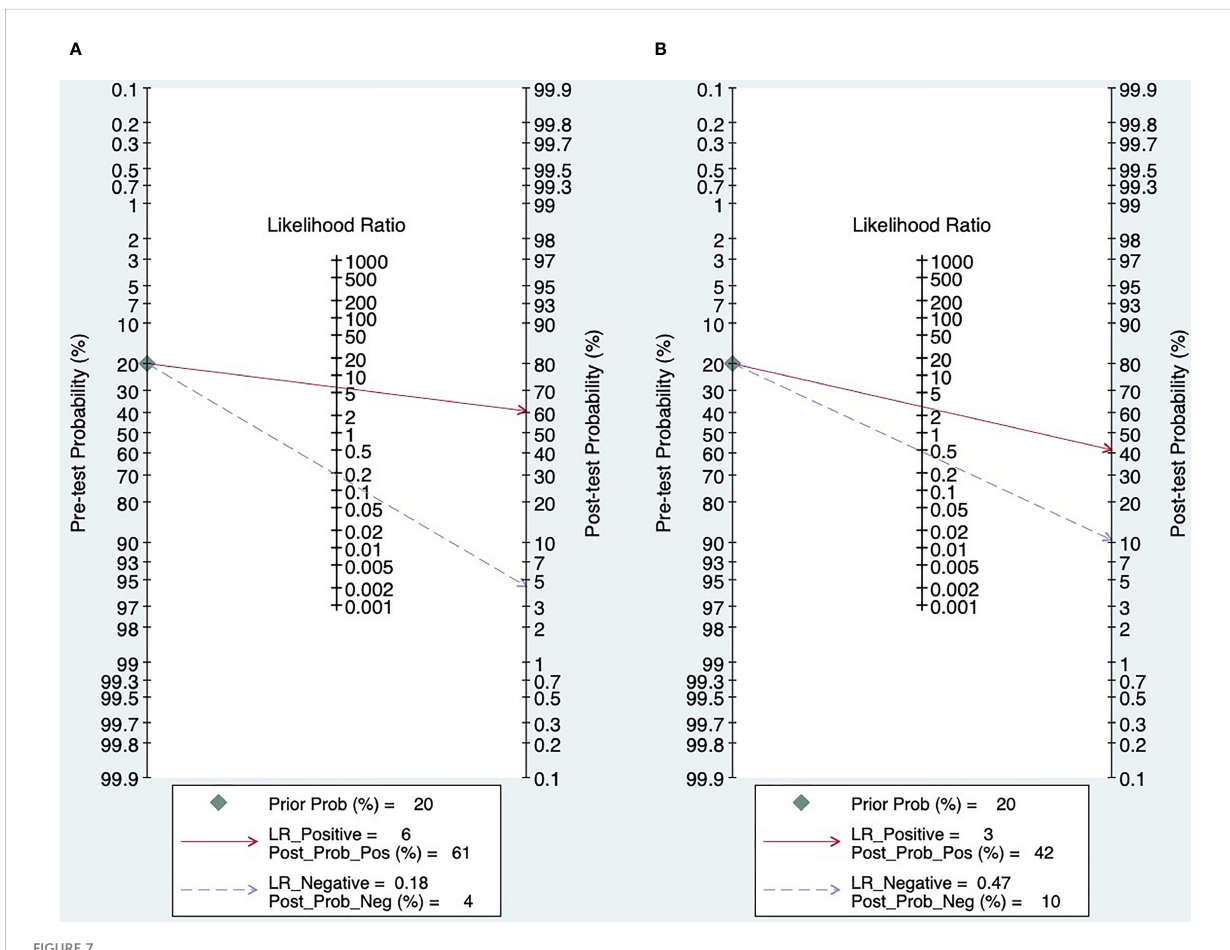
FIGURE 7 Fagan ’ s plot ( A . SMI; B .